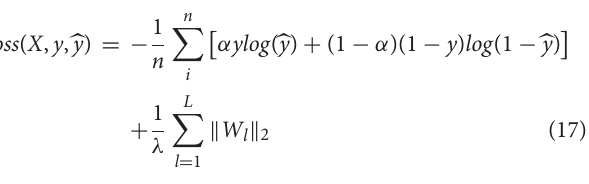
where N is the number of patient nodes. G ( j , k ) indicates the weight between gene j and